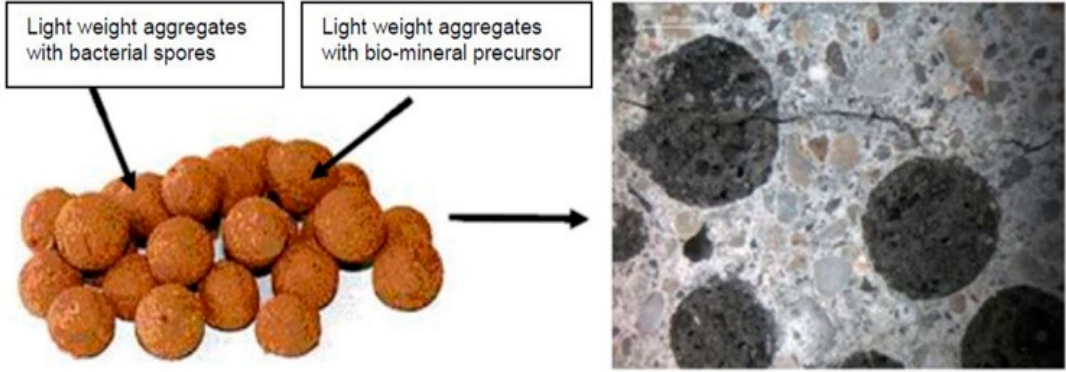
Figure 3. Self-healing blend consisting of expanded clay particles ( left ) loaded with bacterial spores and mineral biological compound (calcium lactate). When incorporated into concrete (to the right